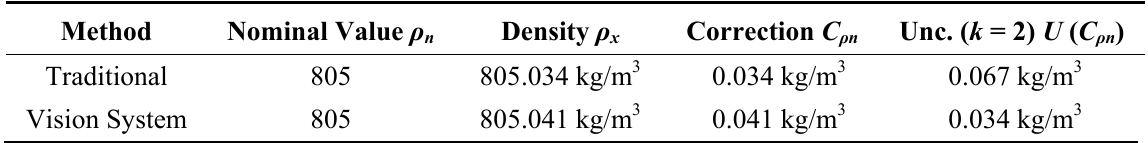
Table 8. Calibration results of the high accuracy hydrometer.